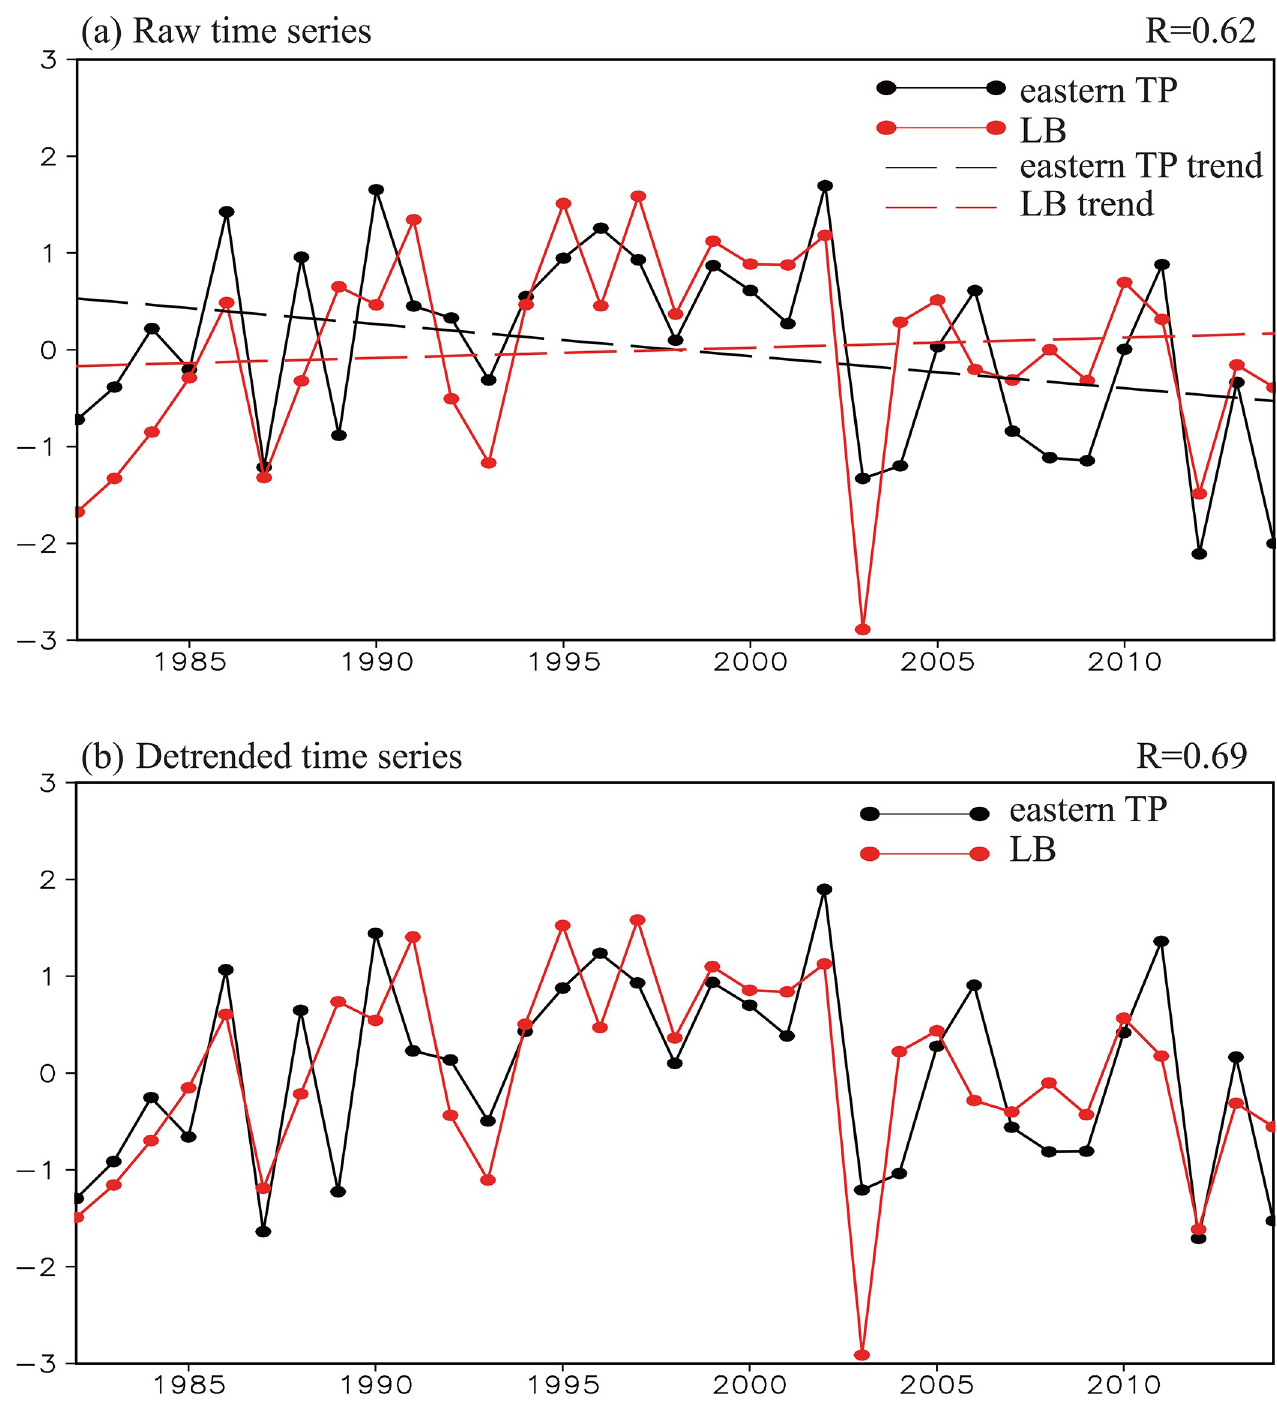
Fig 3. (a) Normalized time series of the summer Tibetan Plateau (black line) and Lake Baikal (red line) NDVI indices during the period 1982–2014. The black and red dashed lines denote the linear trends of the Tibetan Plateau and Lake Baikal NDVI indices, respectively. (b) Normalized time series of the summer Tibetan Plateau (black line) and Lake Baikal (red line) NDVI indices during the period 1982–2014 for the detrended time series. The black and red dashed lines denote the linear trends of the Tibetan Plateau and Lake Baikal NDVI indices, respectively. The correlation coefficient is 0.62 for the two raw NDVI indices and 0.69 for the detrended indices, both significant at the 99% confidence level. LB, Lake Baikal; TP, Tibetan Plateau.